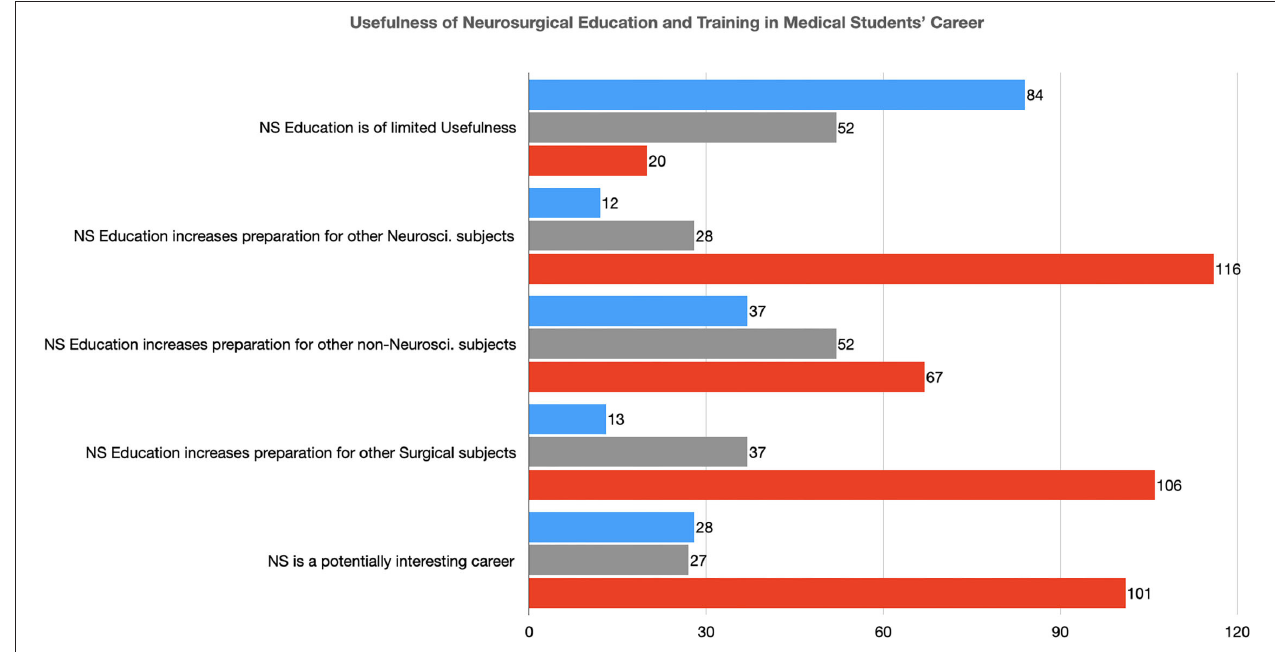
FIGURE 5 | The usefulness of Neurosurgical Education and Training in the Medical Students’ Career (NS, Neurosurgery; Neurosci.,